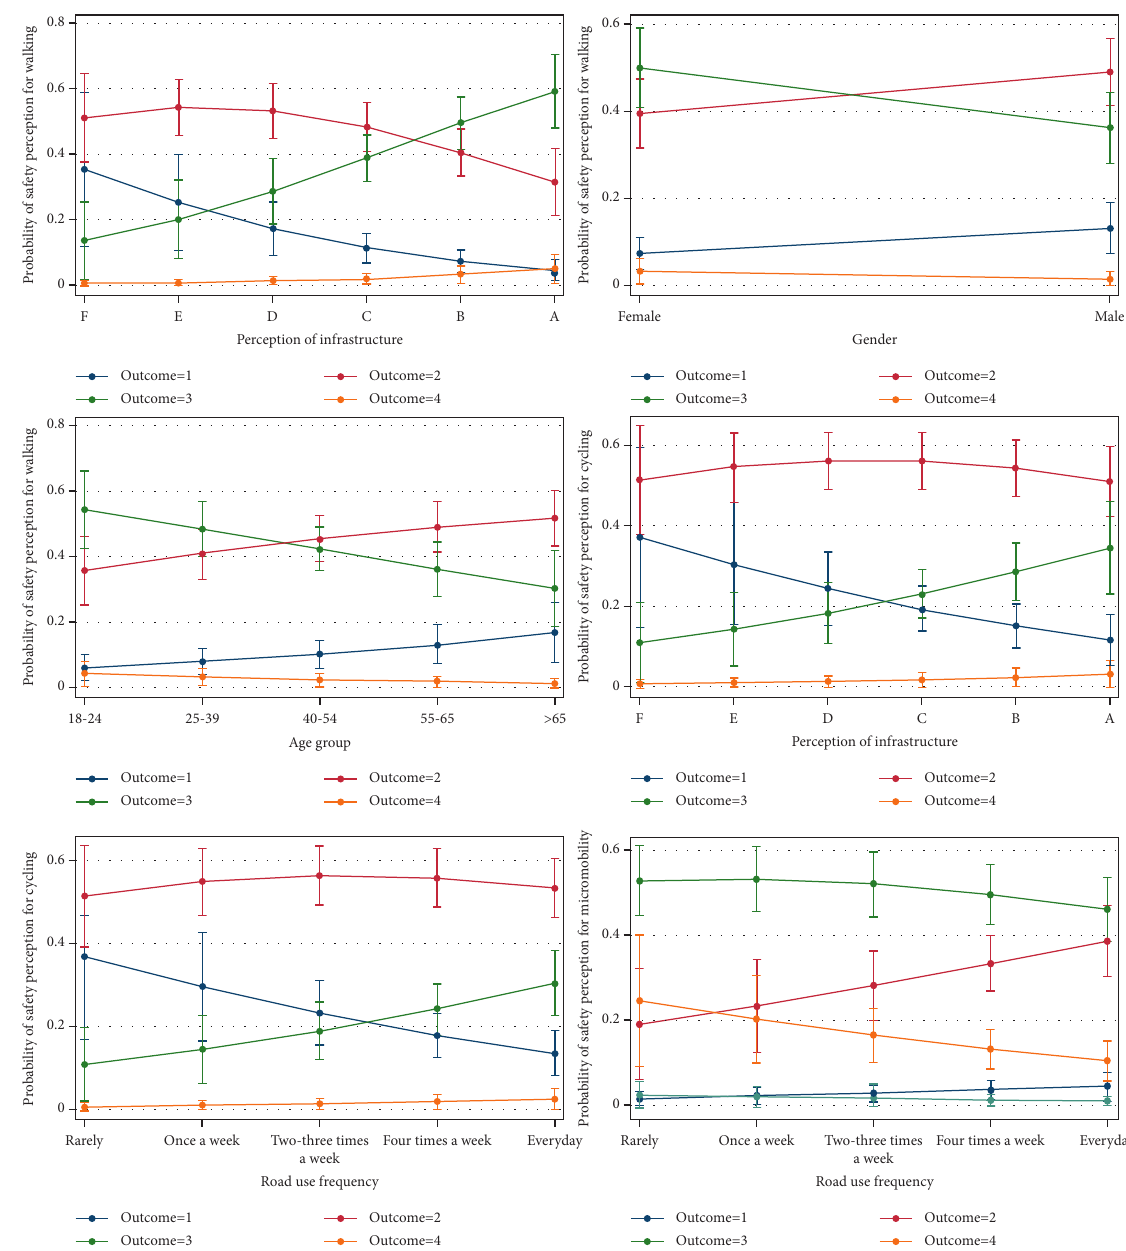
Figure 3: Predictive margins for safety perception at 95% confidence